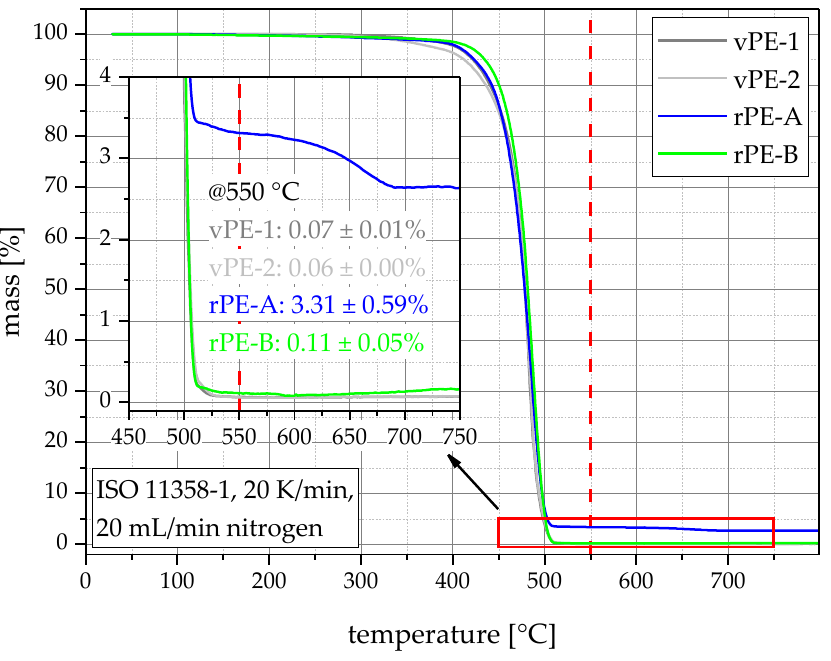
Figure 8. Thermograms of the TGA of all materials with average values and sample standard deviations of the pyrolysis residue at 550 ◦ C (indicated by the vertical red dashed line).